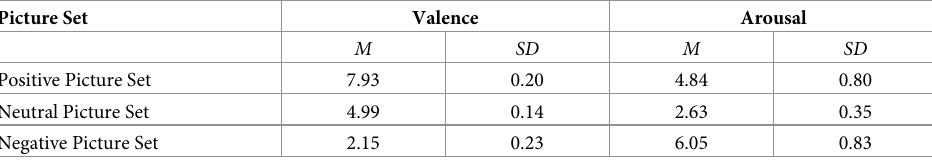
The normative ratings were assessed using the nine-point bipolar scales for valence and arousal of SAM, ranging from 1 (lowest rating) to 9 (highest rating). Hence, higher scores represent a higher rating on each dimension (higher valence, higher arousal).